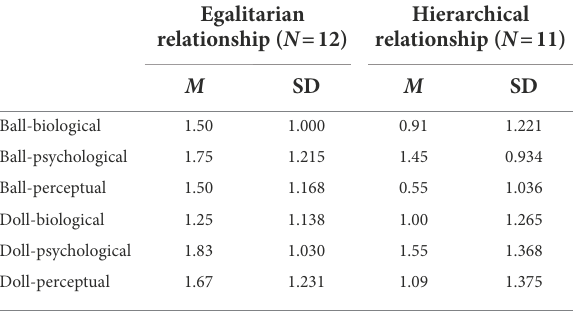
TABLE 7 Mean and standard deviation of agency attributions to ball and doll for child-IC relationship quality.